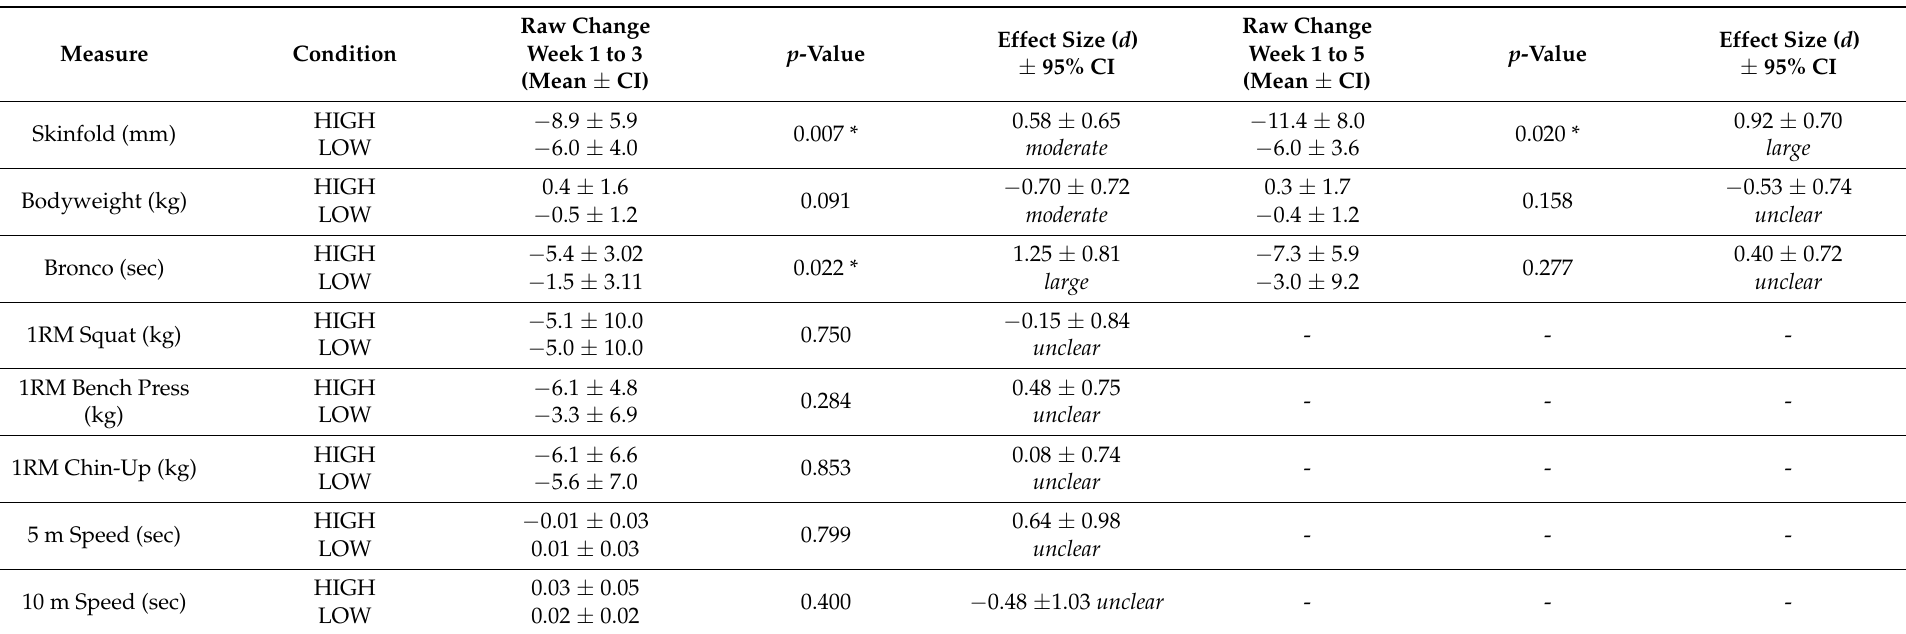
Table 3. Data (mean ± 95% confidence limits) for raw change of physical performance measures between Week 1 and Week 3 and raw changes of skinfold, bodyweight and bronco changes between Week 1 and Week 5 for the HIGH and LOW sleep groups including p -values and effect size comparisons between groups.